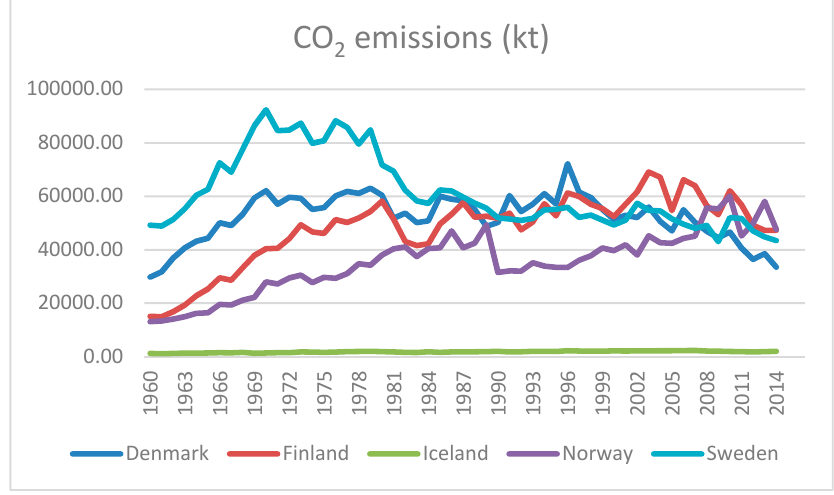
Figure 2. CO 2 emissions of the Nordic countries between 1960 and 2015. Data source: [44].